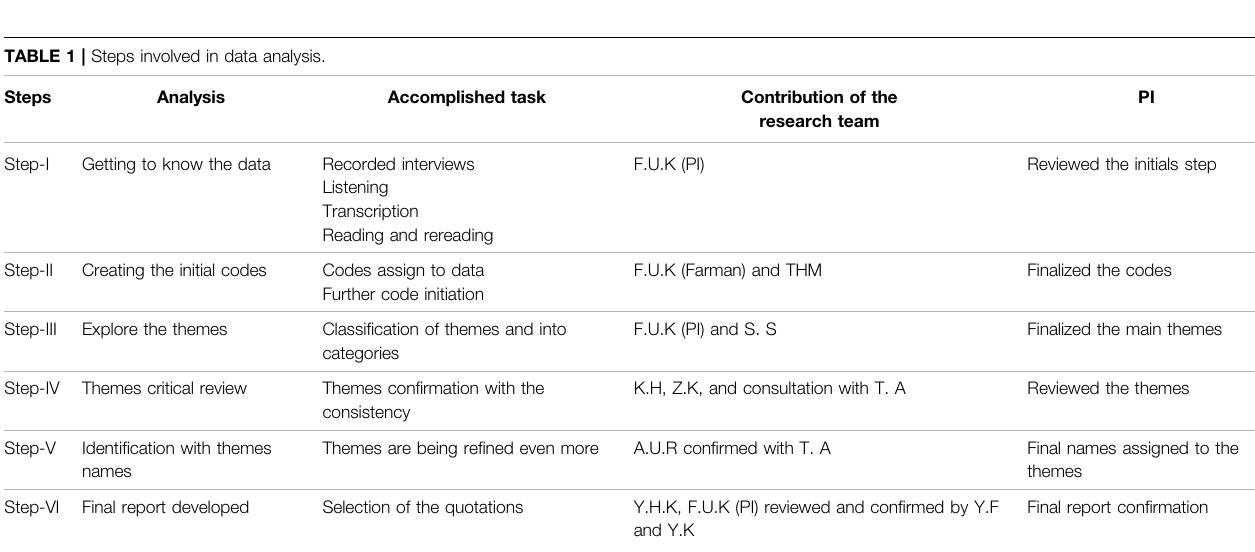
TABLE 1 | Steps involved in data